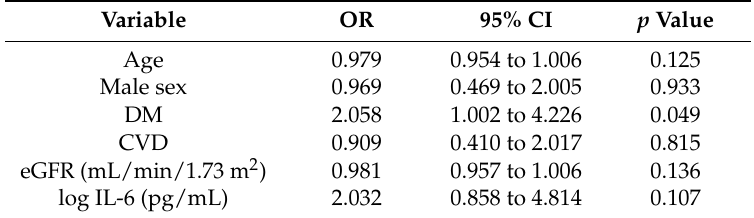
Table 3. Multivariate logistic regression model for patients with low LTI (<10% of the normal value). Abbreviations: CI, confidence interval; CVD, cardiovascular disease; DM, diabetes mellitus;